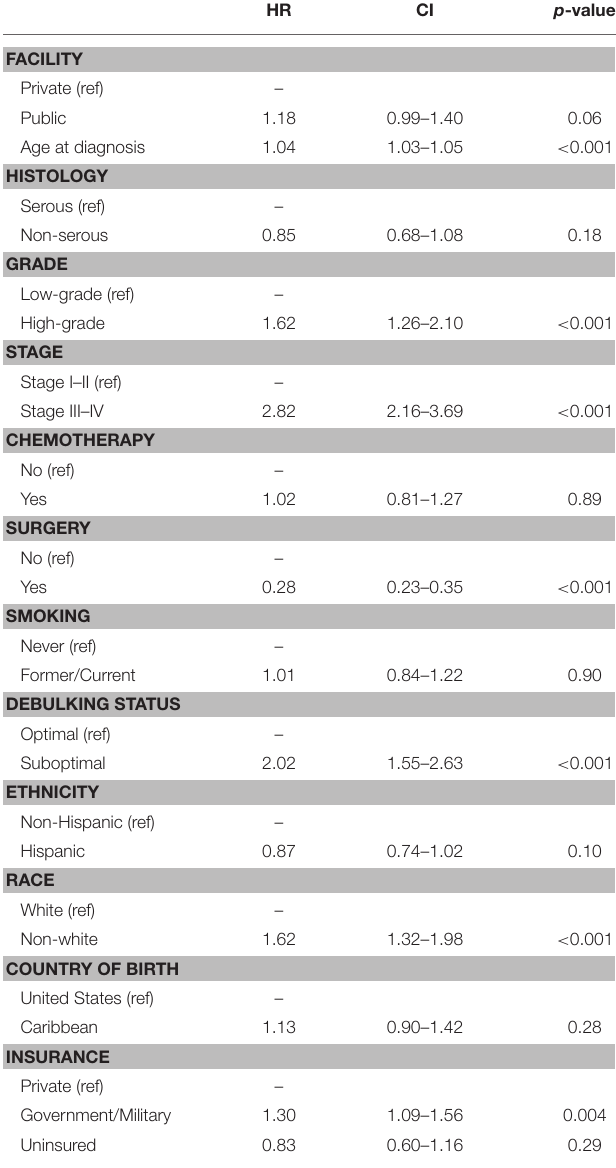
TABLE 2 | Cox proportional hazards modeling of overall survival for the entire cohort. HR CI p -value